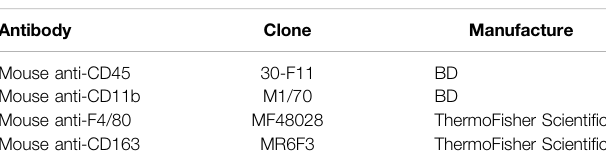
TABLE 1 | Antibody